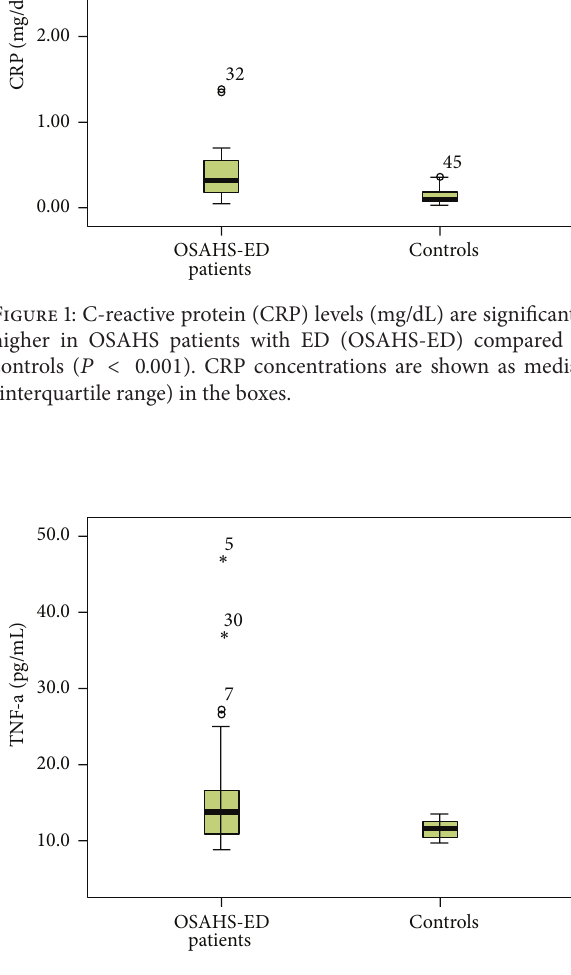
Figure 2: Tumor necrosis factor- 𝛼 (TNF-a) levels (pg/mL) are significantly higher in OSAHS patients with ED (OSAHS-ED) compared to controls ( 𝑃 = 0.01 ). TNF-a concentrations are shown as median (interquartile range) in the boxes.